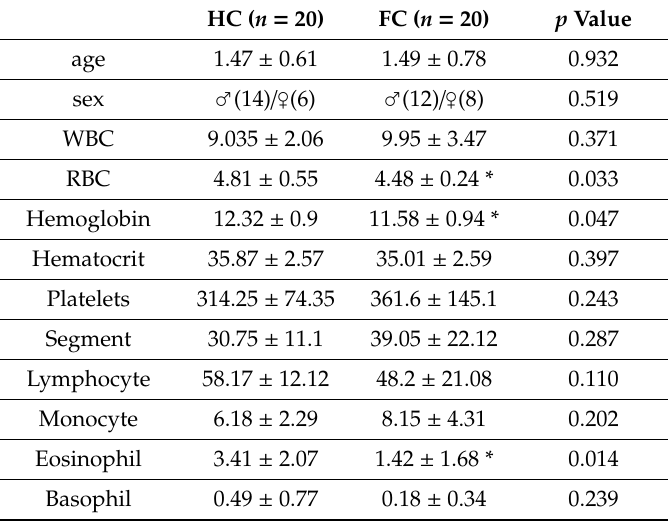
Table 1. Demographic and Clinical Characteristics of Enrolled